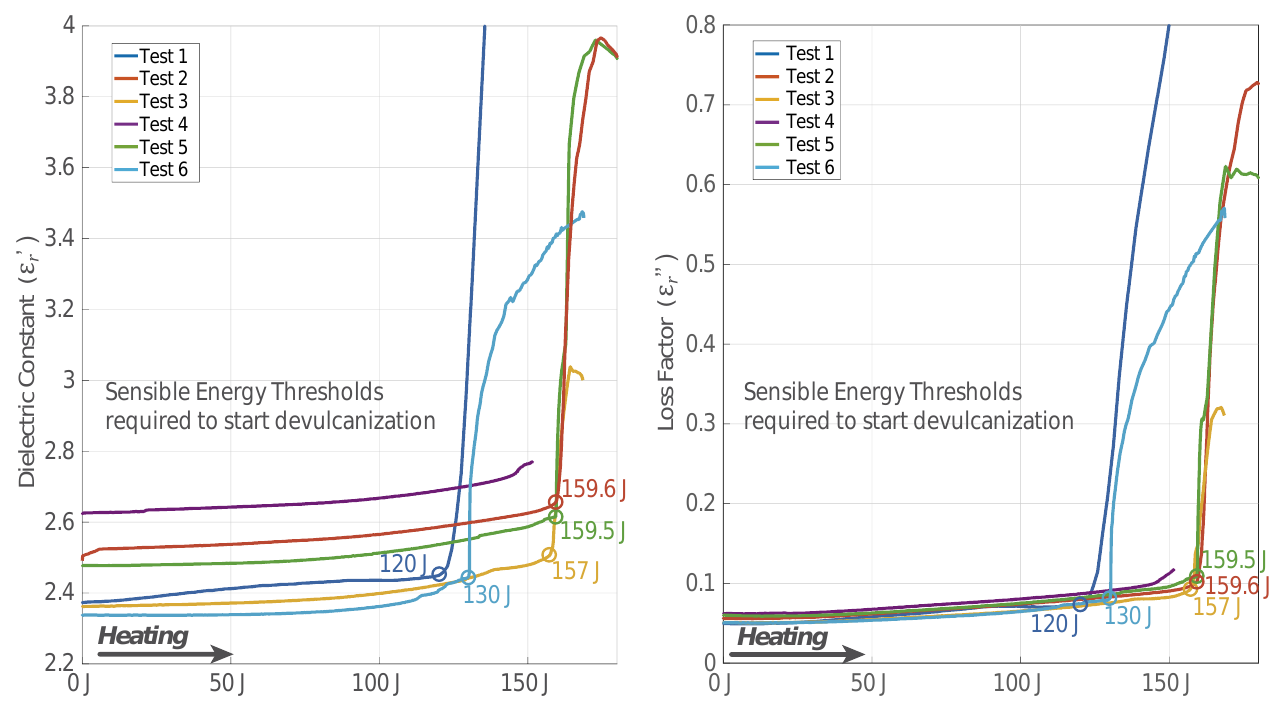
Figure 10. Permittivity behavior versus sensible absorbed energy while heating. Curve kinks are emphasized with a circle showing the energy value at that point.